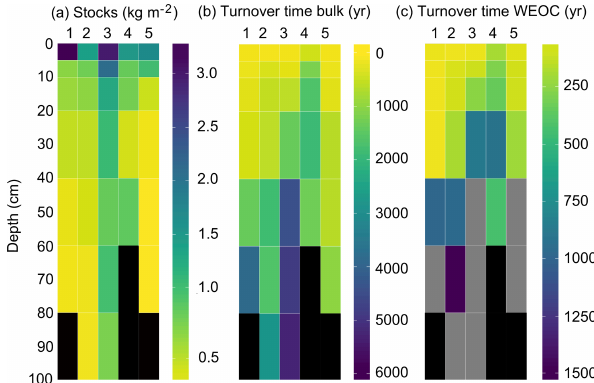
Figure 5. Carbon (a) stocks in the mineral soil (kgCm − 2 ), (b) turnover time bulk soil in years, and (c) turnover time water- extractable organic carbon soil in years. Locations are ordered from the warmest to coldest sites, i.e., (1) Othmarsingen (Luvisol), (2) Lausanne (Cambisol), (3) Alptal (Gleysol), (4) Beatenberg (Pod- zol), and (5) Nationalpark (Fluvisol). Gray boxes indicate the ab- sence of material; black boxes indicate the occurrence of the C hori- zon (poorly consolidated bedrock-derived stony material or bedrock itself).